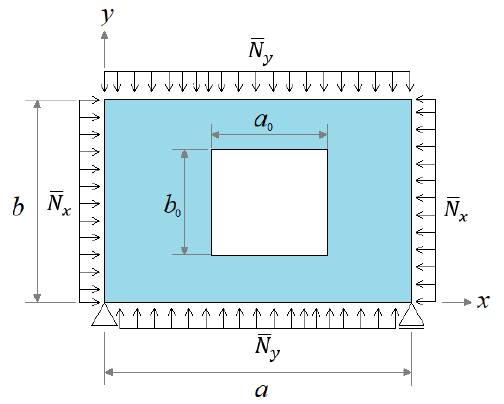
Figure 4. Simply supported square plate with centered square hole.